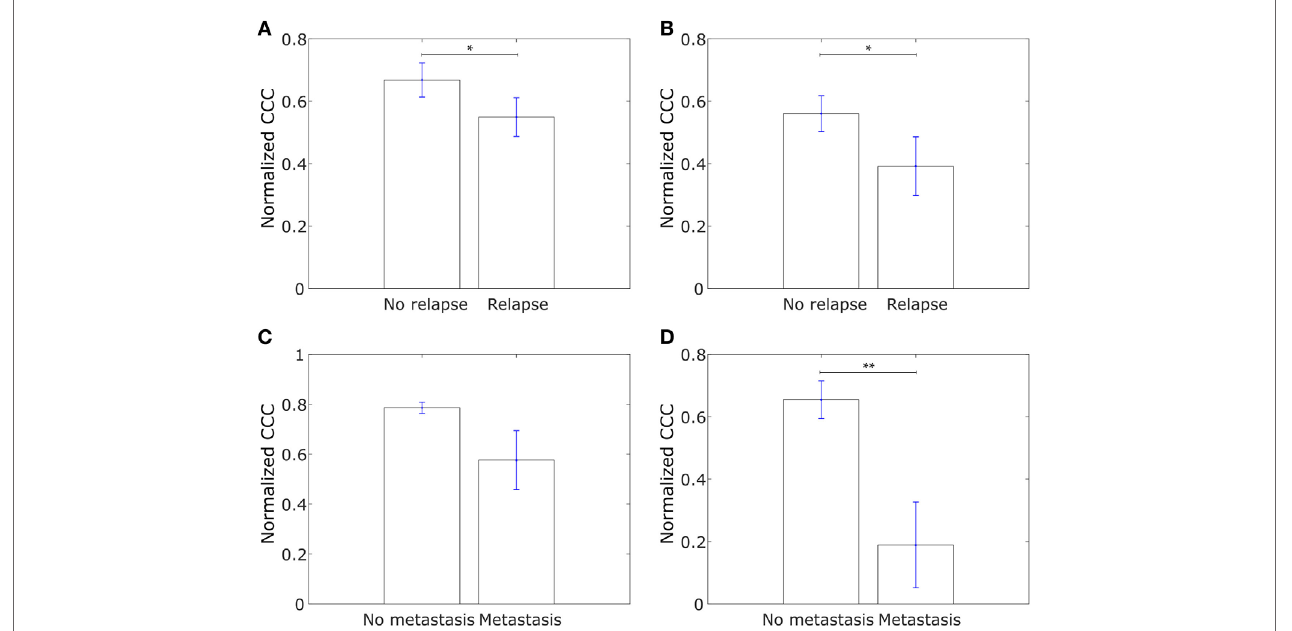
FigUre 8 | (a) Normalized cophenetic correlation coefficient of the collective dissemination-associated gene network for tumor samples from 107 breast cancer patients who did not exhibit breast cancer relapse during the follow-up period and for tumor samples from 179 patients who exhibited metastatic relapse during the follow-up period. Gene expression data from the study by Wang et al. (53). (B) Normalized CCC of the Inflammatory breast cancer-associated gene network for the same patient groups as in (a) . (c) Normalized CCC of the collective dissemination-associated gene network for tumor samples from 527 breast cancer patients with no metastasis during the follow-up period and for tumor samples from 13 patients with breast cancer metastasis during the follow-up period. Gene expression data from the cancer genome atlas (TCGA) (60). (D) Normalized CCC of the IBC-associated gene network for the same patient groups as in (c) . Error bars indicate the SE in the estimate of CCC norm calculated using the bootstrap method. * p -value < 0.05 and ** p -value <